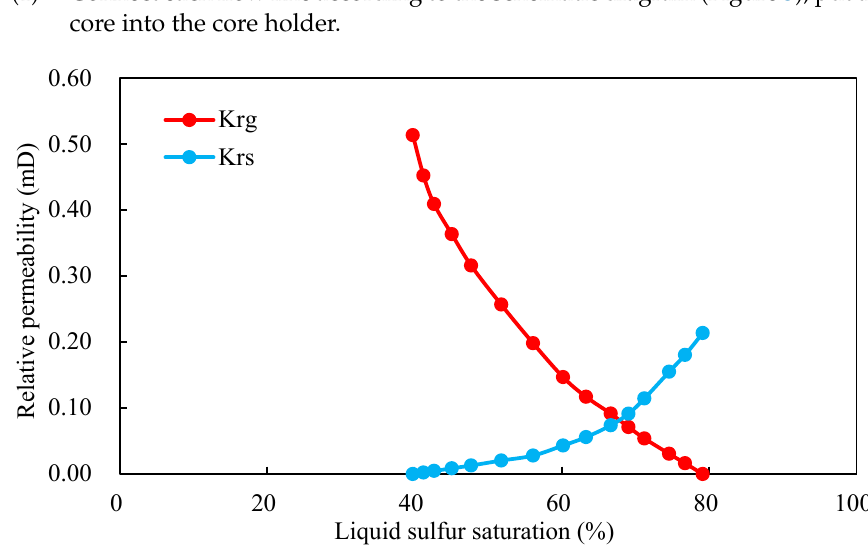
Figure 3. Gas–liquid relative permeability curve of Core 1. Table 4. Experimental scheme.